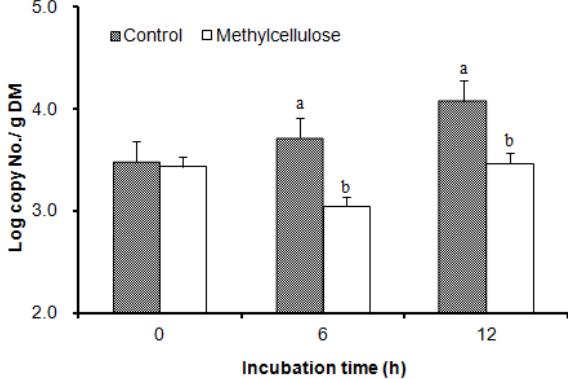
Figure 7. Attachment of Ruminococcus albus as influenced by rice straw pre-treatment with MC (methylcellulose). a,b Means with different letters differ significantly (p<0.05).